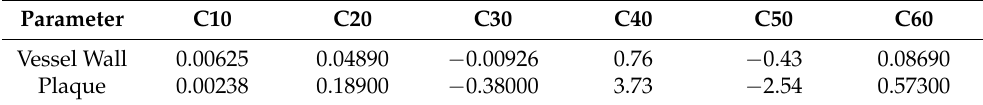
Table 2. The diffusion coefficient of hydrogen in various elements.